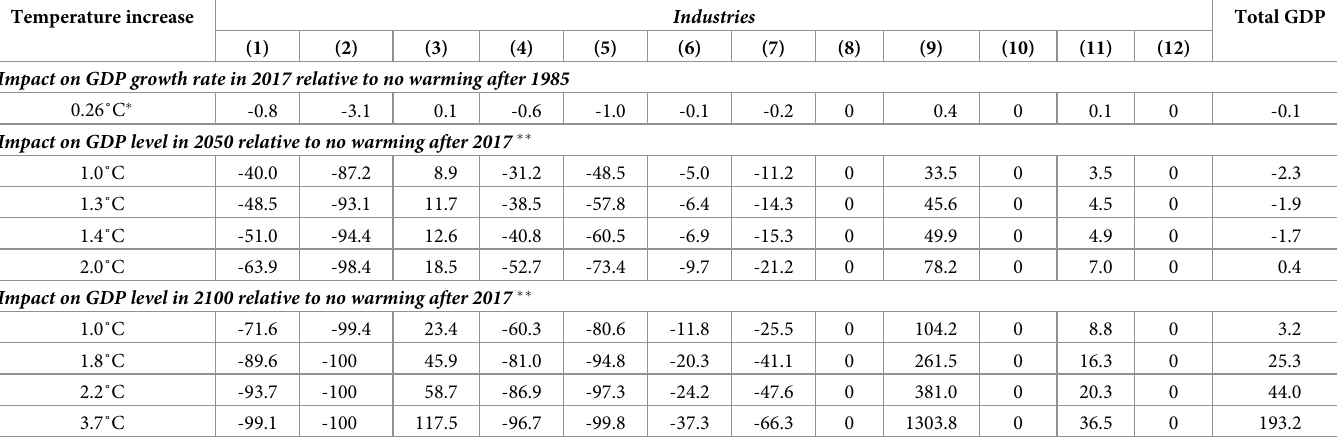
Table 8. Simulated impact of the climate change on the industry, overall GDP and growth rates in Chile: Only stat. significant coefficients (monthly, Table 5). Temperature increase Impact on GDP growth rate in 2017 relative to no warming after 1985 0.26˚C � Impact on GDP level in 2050 relative to no warming after 2017 ��